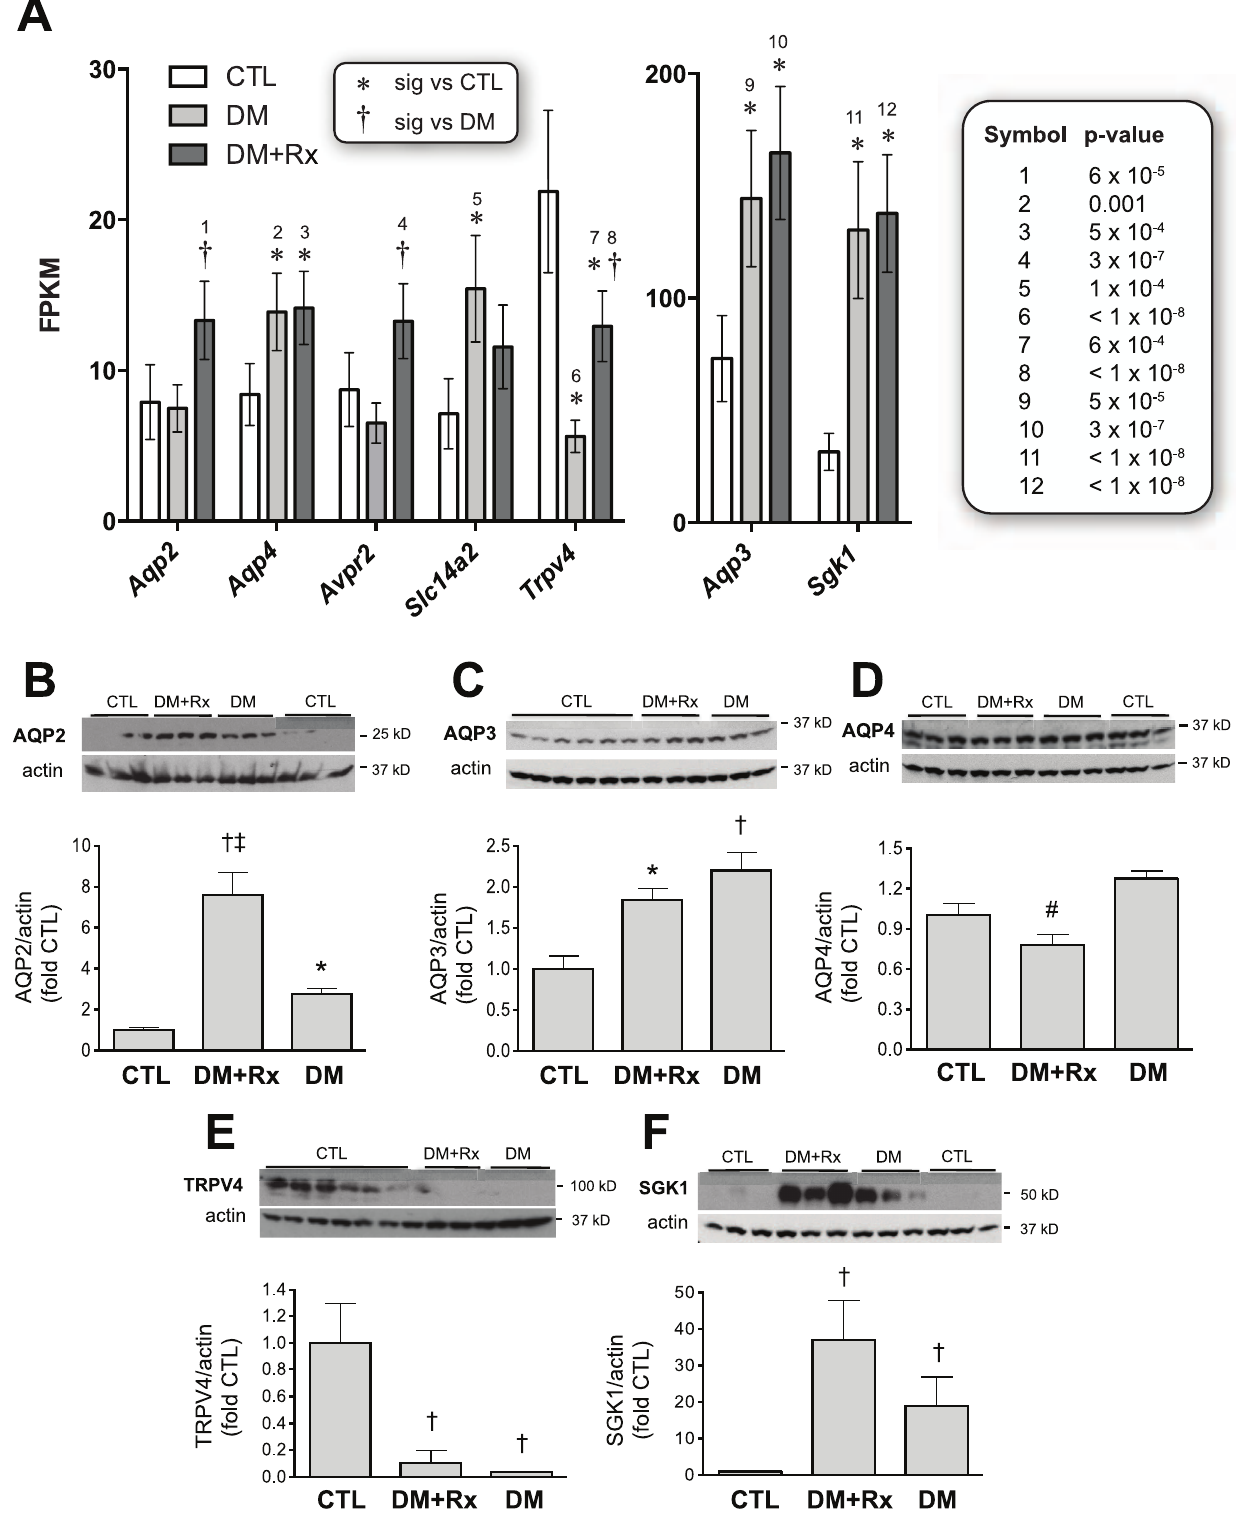
Figure 7. Effect of experimental conditions upon water-balance genes. A. A module of mammalian water balance genes was affected under one or more experimental conditions in the present model. Depicted genes are instrumental in water handling in the distal nephron, or in central osmosensing. Data are represented as FPKM (i.e., expression normalized within-sample). Depending upon gene product, data are scaled to relatively low (left panel) or high (right panel) maximal expression. Several diabetes-associated changes are unaffected by losartan treatment ( Aqp4 , Aqp3 , Sgk1 ), presumably owing to an inability of losartan to correct osmotic derangement associated with hyperglycemia. In contrast, the diabetes-